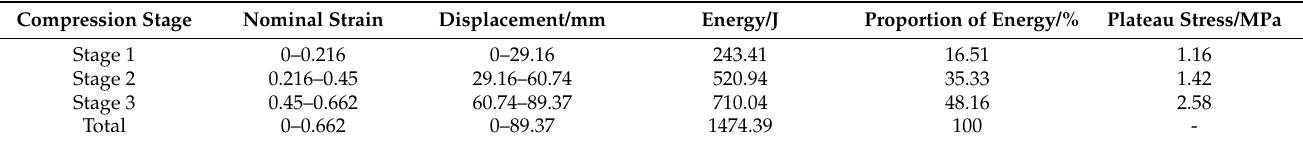
Table 4. The energy absorption of the foam concrete-filled honeycomb ( t = 0.2:0.2:0.2 and ρ = 408:575:848, 1 m/s) in each compression stage.